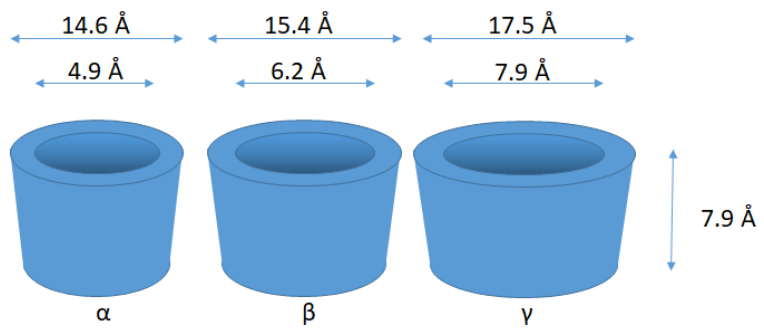
Figure 7. Various dimensions of cyclodextrins.